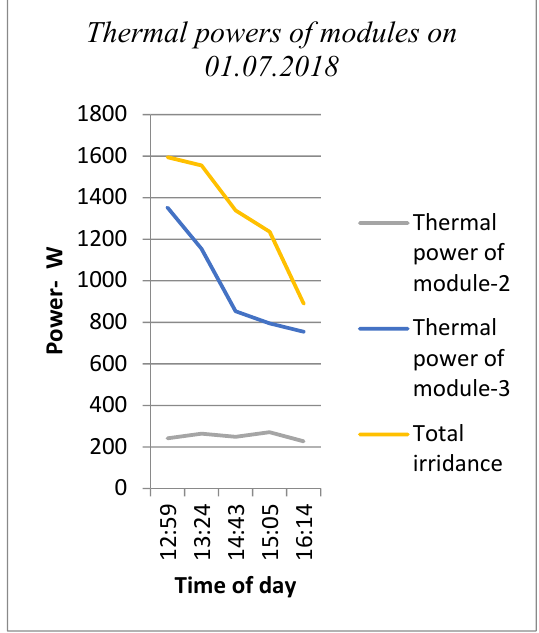
Figure 13. Thermal powers of modules on01.07.2018.